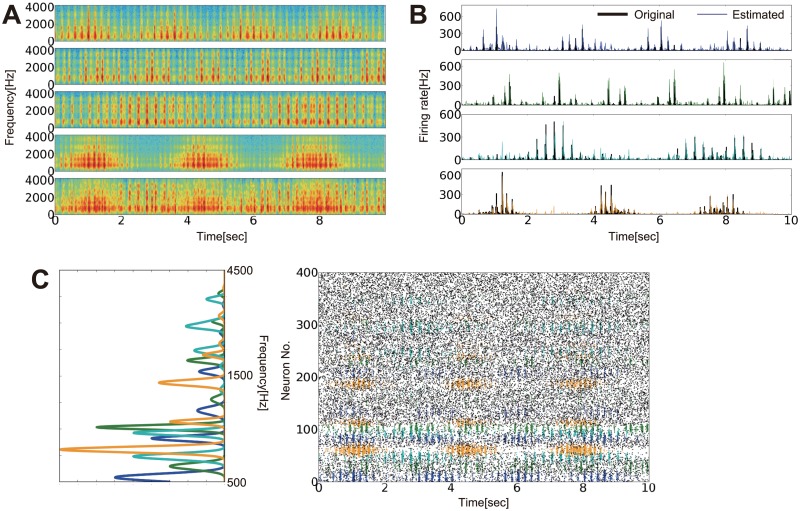
Blind source separation by spike-timing-dependent plasticity (STDP).(A) Four original auditory signals (from the top to the fourth set of signals) and one mixed signal (bottom). (B) Amplitudes of original signals (black lines) and those estimated from output firing rates (colored lines). (C) Spectra of auditory sources a
q
h(f) (left). Raster plots of input neuron activity. Colors were probabilistically assigned based on expected sources. All figures were calculated from the 30’00”–30’10” portion of the auditory signals and simulation.